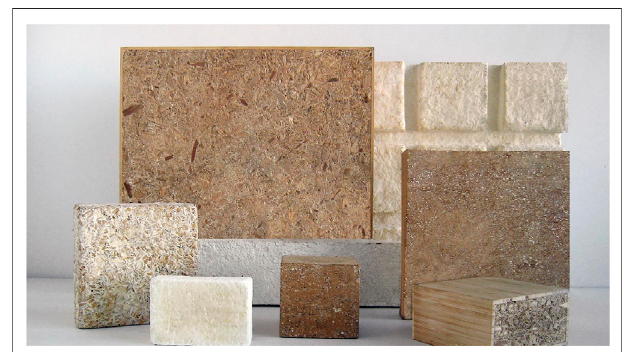
FIGURE 2 | Various mycelium-based panel product samples. Image supplied by Phil